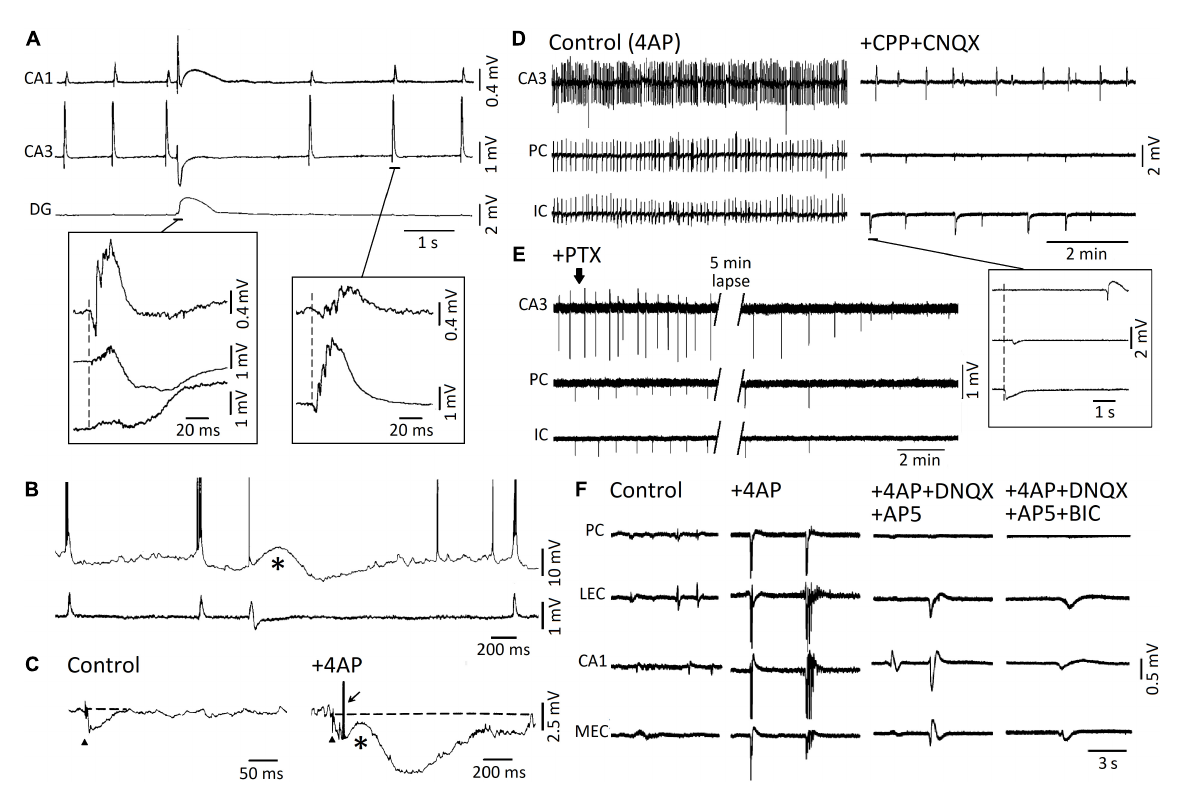
FIGURE2 (A) Simultaneous field recordings obtained from CAI, CA3, and dentate gyrus in an adult rat hippocampal slice during 4AP application. Note that two types of spontaneous interictal spikes are spontaneously generated. The first type is long-lasting and less frequent, it is recorded in all three regions, and it is characterized by a late, “slow” wave; the second type is recorded in CA3 and CA1 only, it is characterized by a short burst of population spikes, and it occurs at a “fast” rate. (B) Simultaneous intracellular (top trace) and field potential (bottom trace) recordings obtained from the CA3 subfield during 4AP application. Note that intracellular bursts of action potentials correlated with the “fast” interictal field events, whereas a long-lasting depolarization corresponded to the “slow” interictal field event. (C) Responses to Schaffer collateral electrical stimulation (triangle) recorded intracellularly from a CA3 pyramidal cell under control conditions and in the presence of 4AP. Note that in control the presumptive recurrent hyperpolarizing IPSP lasts approx. 60 ms while, in the presence of 4AP, the same stimulation induces an initial hyperpolarizing IPSP followed by a slow depolarization (asterisk) and a long-lasting (almost 1 s long) hyperpolarization; the arrow indicates a fractionated, presumably ectopic, action potential that arises from the peak of the early hyperpolarizing IPSP. (D) Simultaneous field potential recordings obtained in an extended brain slice from the hippocampal CA3 area, the perirhinal cortex and the insular cortex under control (4AP) conditions and during application of NMDA and non-NMDA ionotropic glutamatergic receptor antagonists (+ CPP + CNQX). Note in the inset that during ionotropic glutamatergic receptor antagonism, “slow” field potentials continue to occur independently in CA3 from those seen quasi synchronously in PC and IC. (E) Under experimental conditions similar to those described for (D) (+ CPP + CNQX), addition of the GABA A receptor antagonist picrotoxin abolishes the presumptive, “slow” GABAergic field potentials in all areas of the brain slice. (F) Epileptiform activity induced by 4AP arterial application in the piriform cortex (PC), lateral entorhinal cortex (l-EC), hippocampal CA1 subfield, and medial entorhinal cortex (m-EC) of the isolated brain preparation is greatly reduced by ionotropic glutamatergic receptor antagonists (+ DNQX + AP5). The residual field potential events are then abolished by further administration of the GABA A receptor antagonist bicuculline (BIC). (A,B) Are modified from Perreault and Avoli (1992); (C) is modified from Perreault and Avoli (1991); (D,E) are modified from Sudbury and Avoli (2007); (F) is modified from Uva et al.